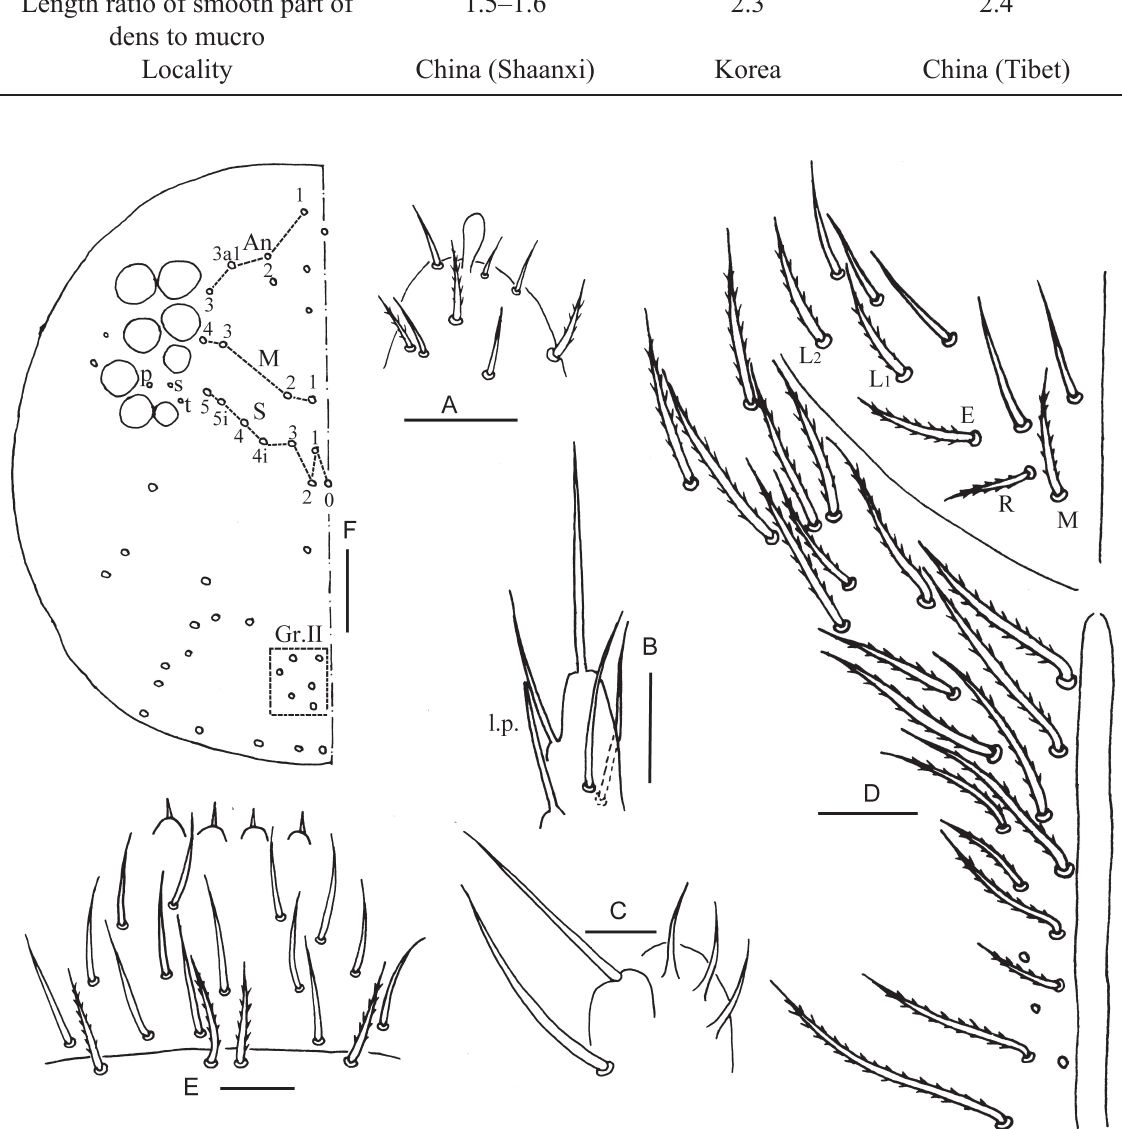
Fig. 7. Entomobrya polychaeta sp. nov. A . Apex of Ant. IV. B . Lateral process of labial palp. C . Maxillary outer lobe. D . Labium. E . Labrum. F . Dorsal chaetotaxy of head. Scale bars: A–C, E, = 20 μm; D, F = 50